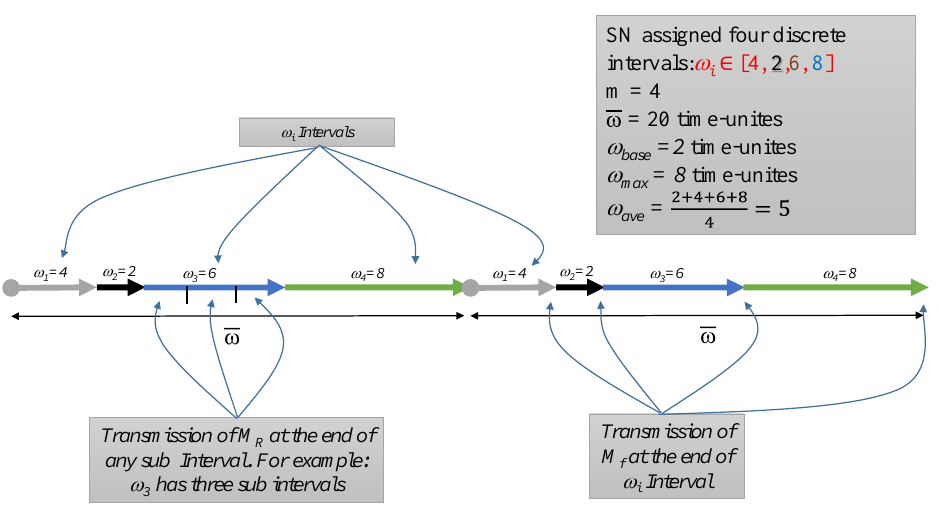
Figure 13. The generation of the sequence of intervals assigned for each sensor. The sequence keeps repeating for the sensor. Fake messages transmitted only at the end of the interval. However, real message could be transmitted at any subinterval.